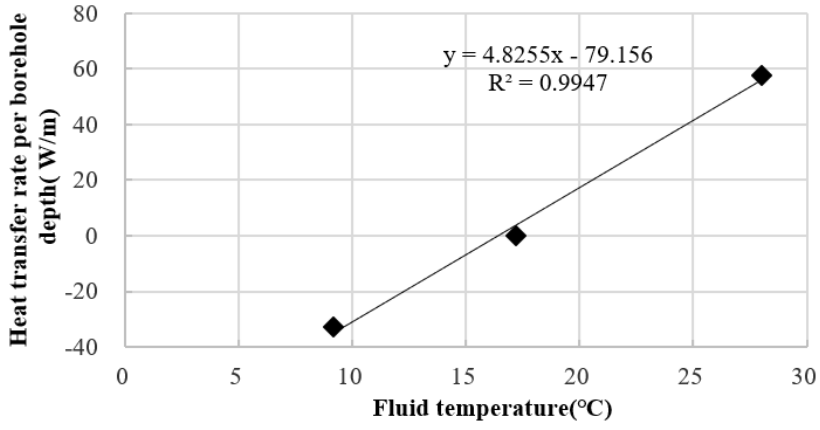
Figure 6. Variation in the heattransfer rate of the BHE with the average fluid temperature. Following the same method, the effective thermal conductivity of the other 14 bore- holes was calculated. The results are shown in Table 7. A higher effective thermal conduc- tivity was determined in BD and SJZ of the piedmont plain with value ranges between 2.37 and 2.68 W/(m · K). The lower value was reported in boreholes of the central plain with values ranging between 1.35 and 1.63 W/(m · K). Results of other boreholes in the coastal plain range between 1.58 and 1.94 W/(m · K). As mentioned in Sections 2.1 and 3.1, the groundwater flow velocity in the piedmont plain was from 0.013 to 0.26 m/d, while in the central and coastal plain it was from 0.002 to 0.10 m/d. The existence of groundwater flow has a significant effect on the temperature profile of the aquifer [46] and the thermal performance of the BHE will be enhanced as a result of groundwater convection. The large difference in groundwater flow velocity in these regions could be the main factor contributing to the difference in thermal